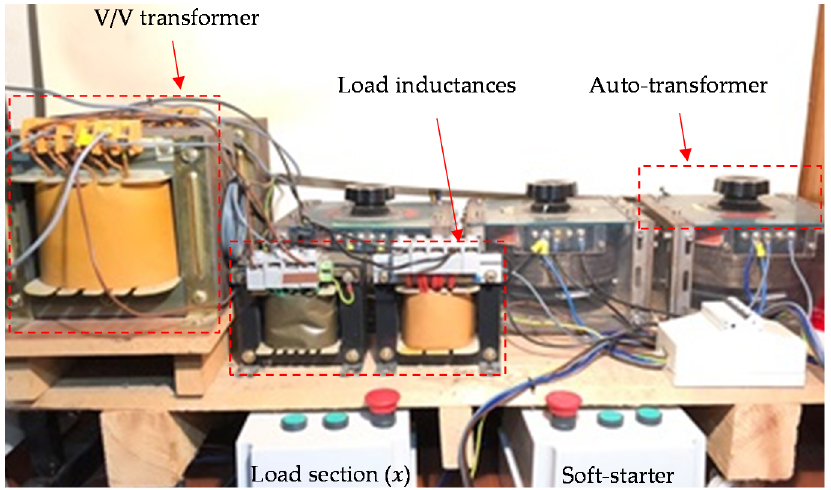
Figure 7. Supplementary power equipment